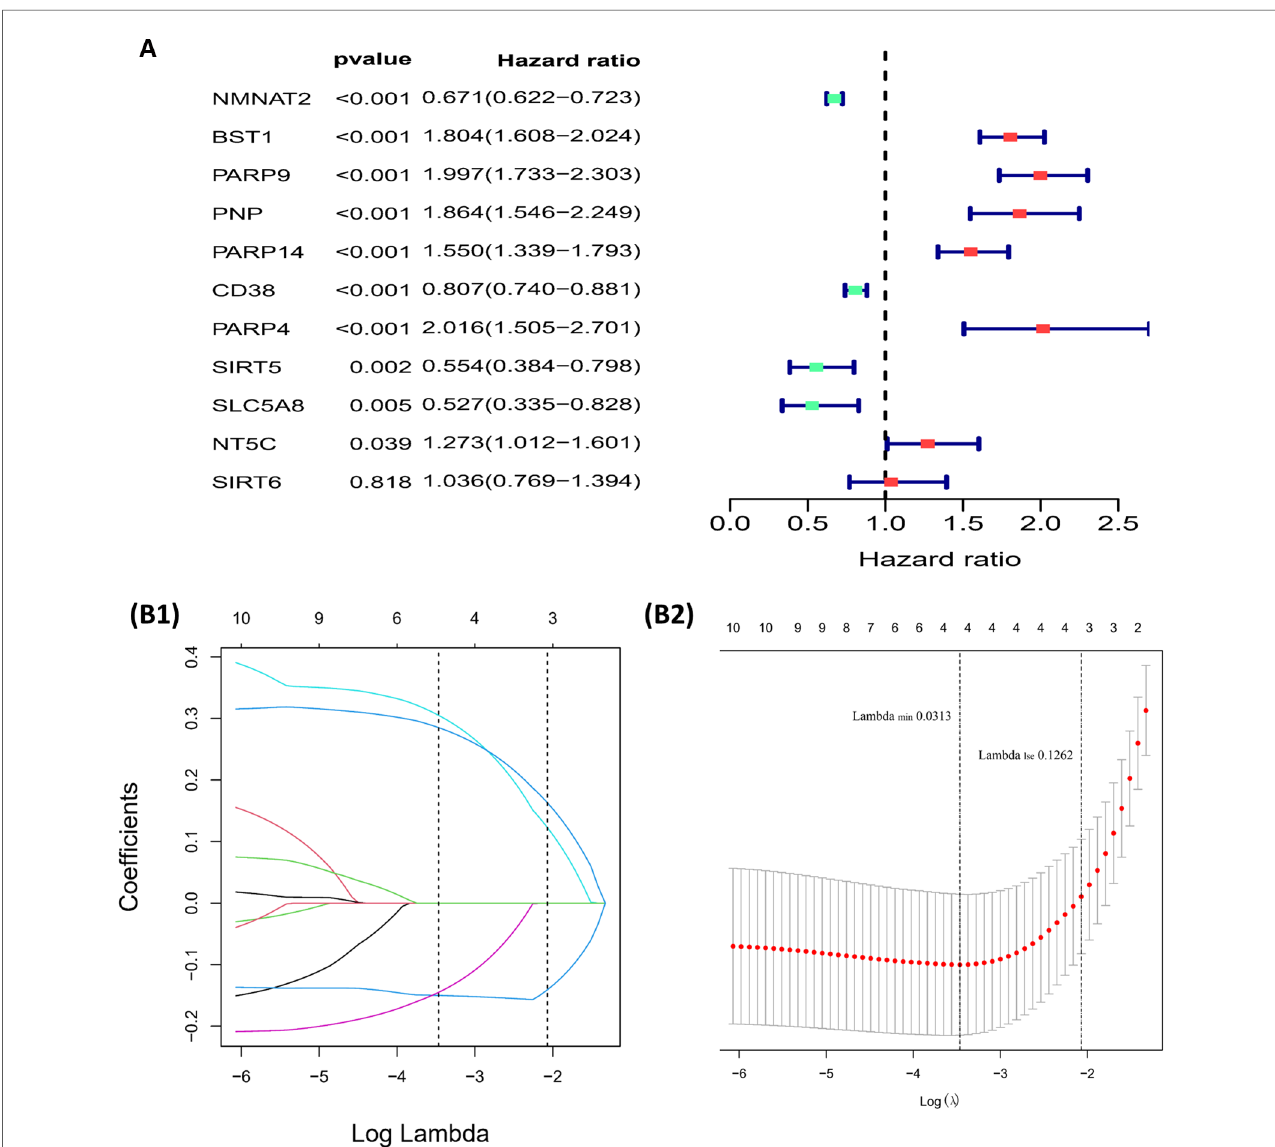
FIGURE 3 Building of the risk model ( A ) forest plot for univariate cox regression analysis. ( B1,B2 ) Plot of gene coef fi cients for Lasso regressions. Error plots for 10-fold cross-validation.